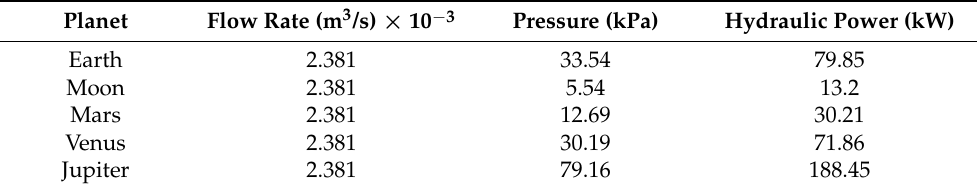
Table 3. Hydraulic power versus the essential flow rate on different planets